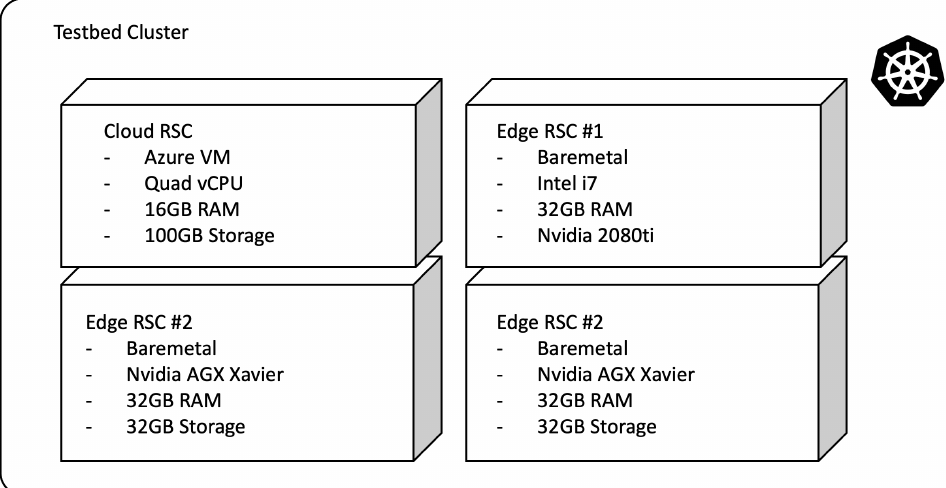
Figure 5. Testbed Configuration.